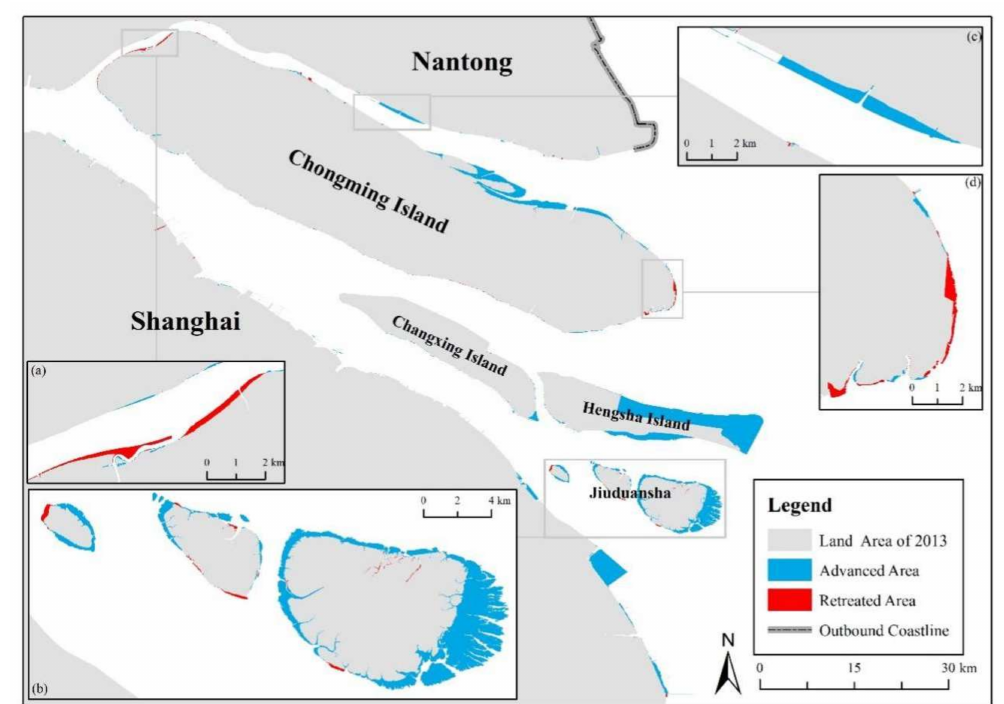
Figure 5. Yangtze River Estuary coastline change from 2013 to 2018: ( a ) typical land erosion, ( b ) Jiuduansha Wetland National Nature Reserve, ( c ) typical land expansion and ( d ) Dongtan Wetland